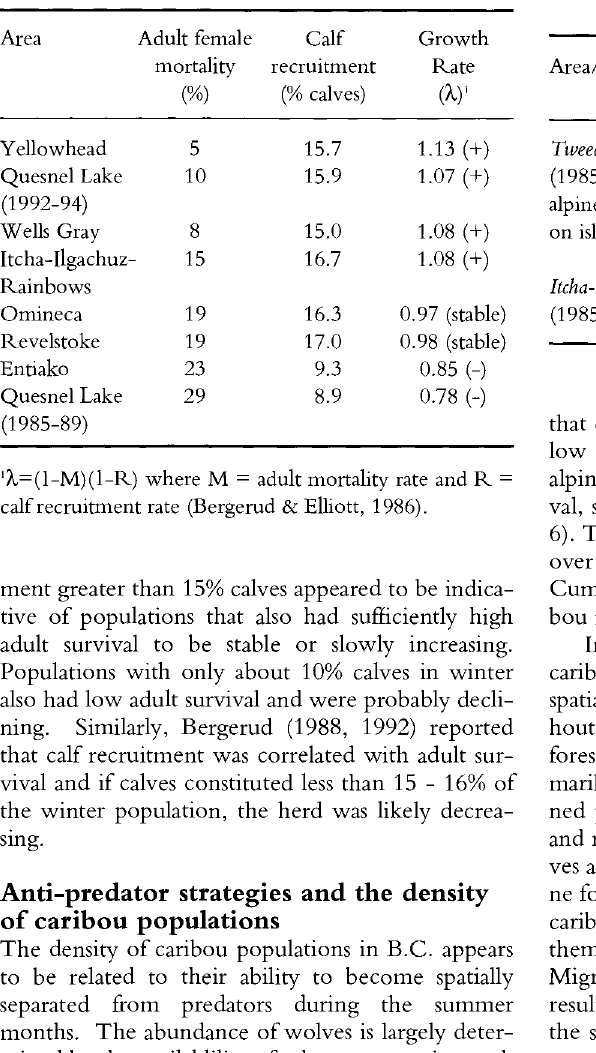
Table 6. Annual adult female mortality, calf recruitment, finite growth rate, and probable population trend of caribou herds in British